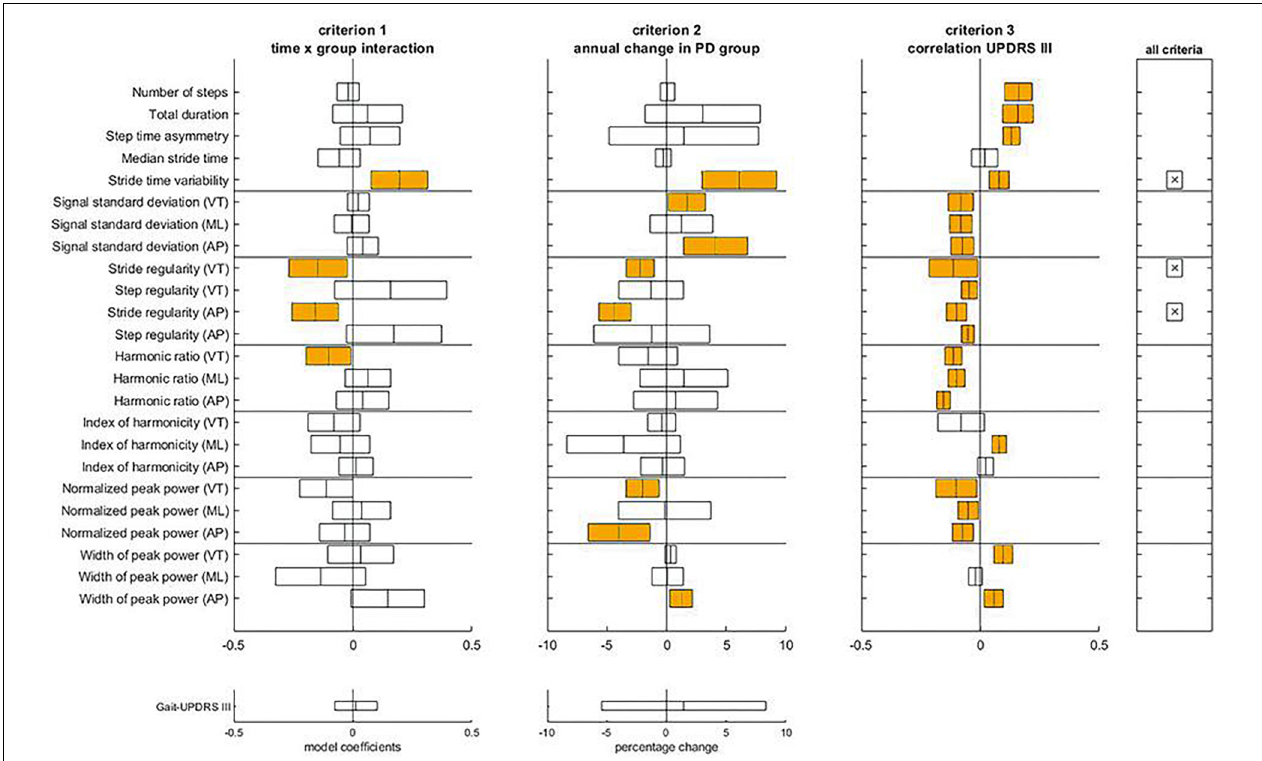
FIGURE 3 | Assessment of the criteria to identify progression makers in Mid-PD. For each gait feature, means and confidence intervals of model coefficients for the interaction of time and group, for the percentage of annual change in the Mid-PD, and for the model coefficient of the regression to gait-UPDRS III scores are presented. The right panel indicates which features satisfy all three criteria. The lower panels provide results for the gait-UPDRS III scores as a reference.